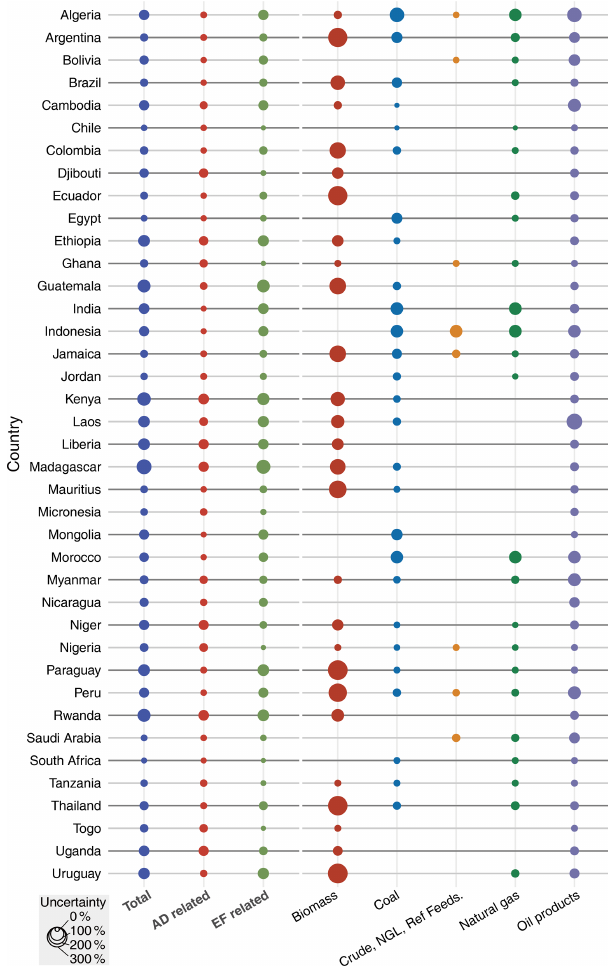
Figure 5. Data uncertainty of total emissions from activity data, from emission factors, and by energy